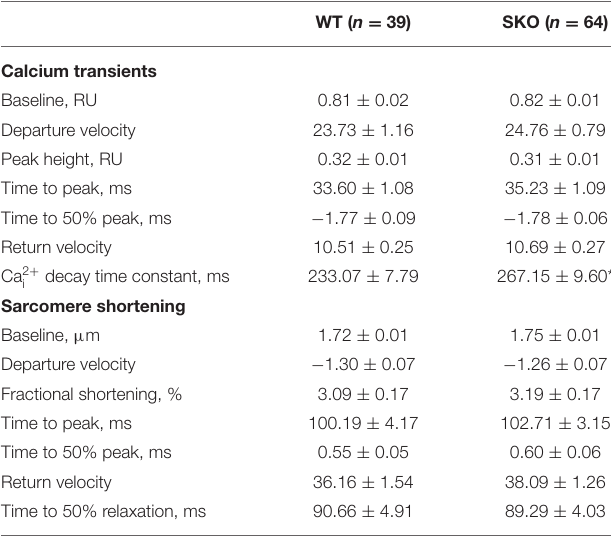
TABLE 2 | Calcium transient currents and sarcomere shortening in ventricular myocytes of SKO mice; [Ca 2 + ]i, cytosolic Ca 2 +